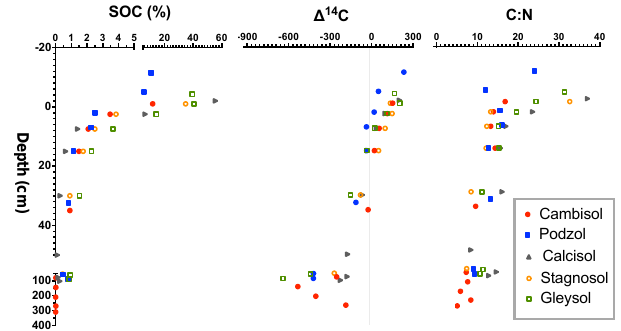
Figure 8. Soil organic carbon (SOC) content, (cid:49) 14 C and C:N ra- tios for five depth profiles of distinct soil types (Cambisol, Podzol, Calcisol, Stagnosol and Gleysol) covering a climatic and altitudinal gradient. Radiocarbon trends are highly similar for four out of five soil types, while carbon content and C:N ratio varies for each soil type. The Podzol shows a different trend, with (cid:49) 14 C consistently lower in the topsoil. Analytical errors are smaller than symbol sizes and are not visible (between 6 and 8‰ (cid:49) 14